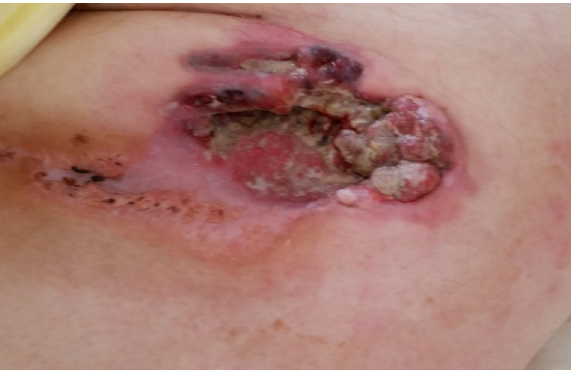
Figure 4: Shrinkage of the groin metastasis during the treatment.